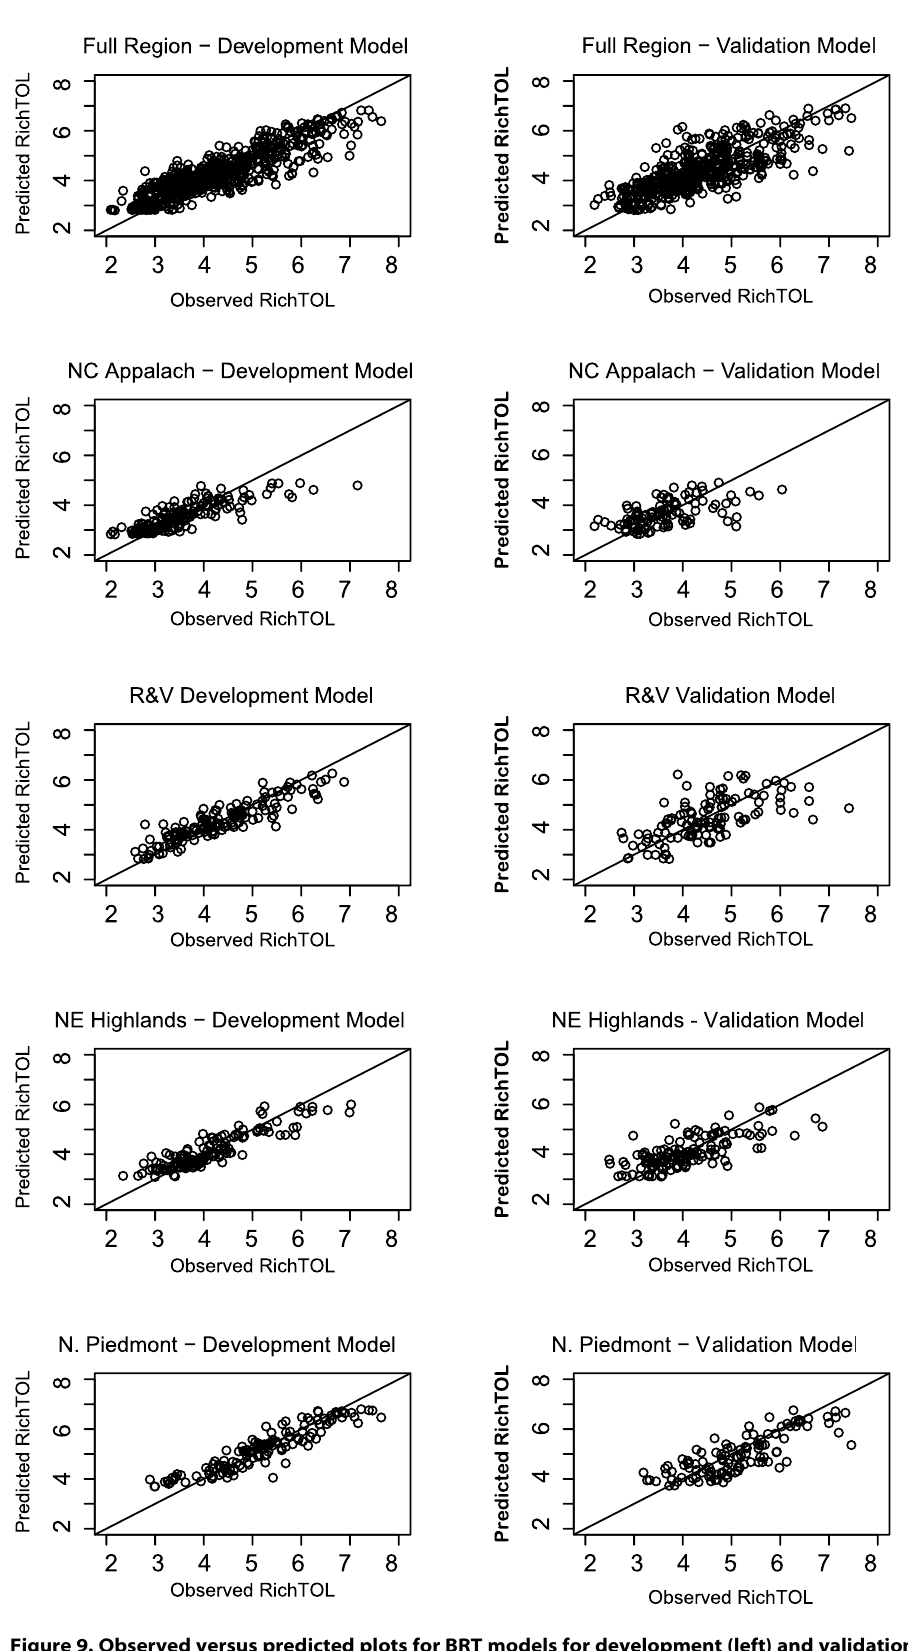
Figure 9. Observed versus predicted plots for BRT models for development (left) and validation (right) data sets. The observed versus predicted plots are based on the boosted regression models developed for average taxa tolerance (RichTOL) for five models: Full Region and four individual ecoregions (NC Appalachian, Ridge and Valley, NE Highlands, and N. Piedmont). The Full Region and N. Piedmont region plot relatively